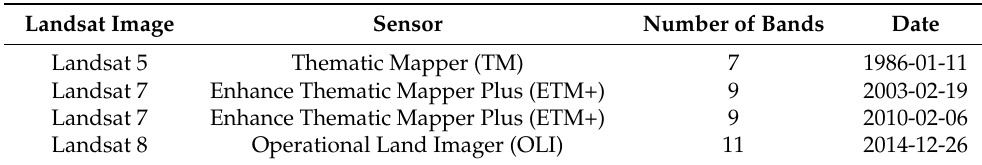
Table 2. Details of Landsat images and the various bands. Landsat Image Sensor Number of